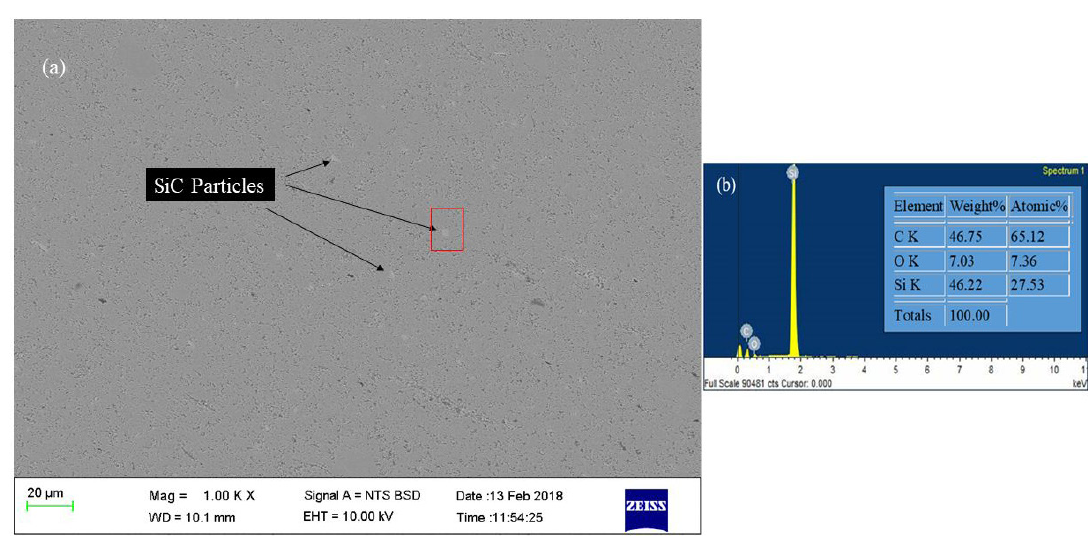
O -20 vol% SiC composite sintered at 1500°C (b) EDS spot analysis results for Al 2 3